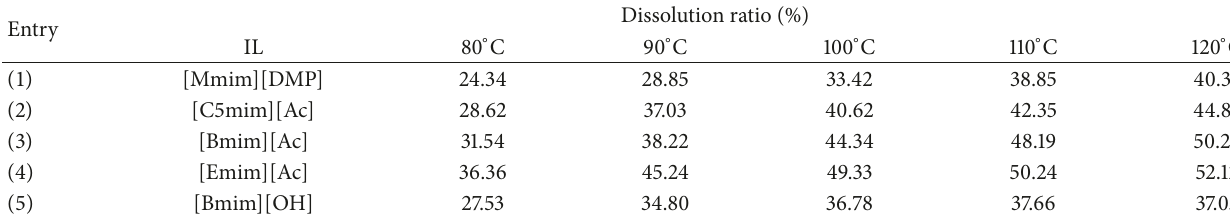
Table 2: Dissolution ratio of biomass in the ILs at different temperatures.